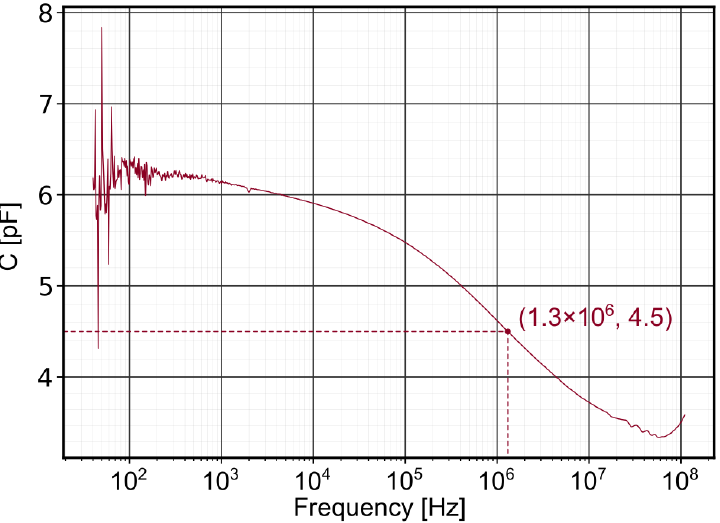
Figure 4. Capacitance of the PVDF sensor (1mm 2 ) with an oscillator level of 500mV over a range of 40Hz to 500MHz.